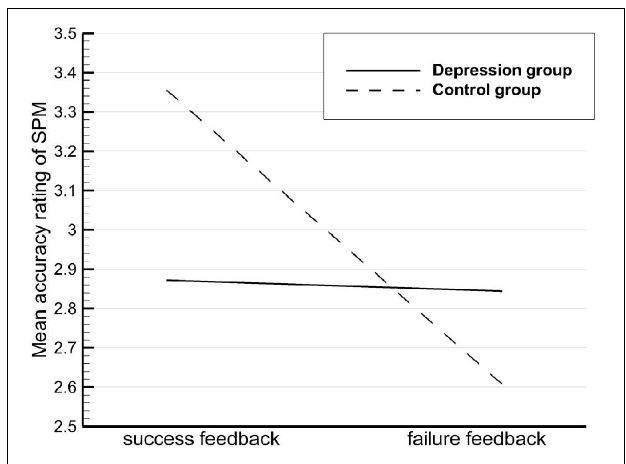
FIGURE 2 | Mean Raven’s Standard Progressive Matrices (SPM) accuracy ratings by participant type and feedback